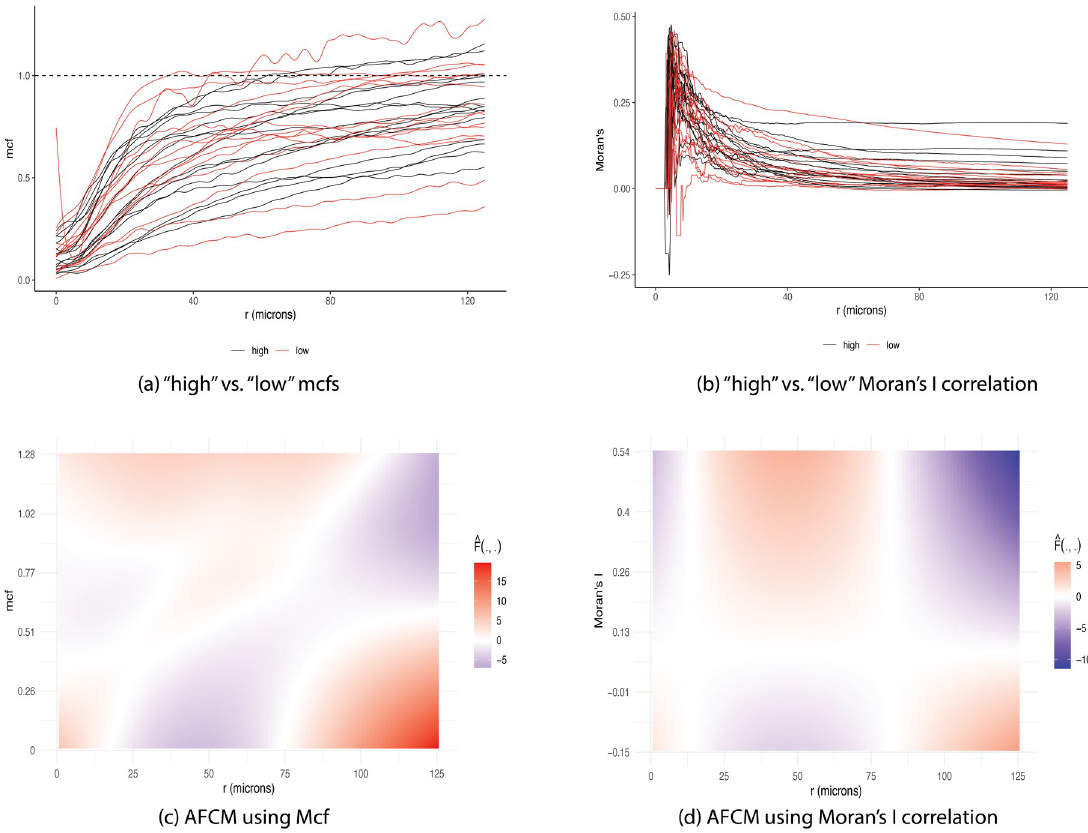
Fig 4. Estimated surface from AFCM using NSCLC dataset. (A) Mcf curves corresponding to “low” survival (i.e., shortest survival times) and “high” survival (i.e., longest observed censored times) patients in red and black, respectively. Note that mcf values below 1 indicate strong clustering of cells of same type, while values above 1 suggest higher level of mixing in of the two cell types. (B) Moran’s I correlation using MHCII expression corresponding to “low” survival (i.e., shortest survival time) and “high” survival (i.e., longest observed censored time) patients in red and black, respectively. Moran’s I values above 0 indicate a direct relationship in MHCII expression between tumor and stromal cells. Negative Moran’s I values suggest an inverse association in MHCII expression between tumor and stromal cells. (C) Estimated surface from AFCM using mcf curves as functional covariates with values decreasing from positive (red) to negative (blue). (D) Estimated surface from AFCM using Moran’s I correlation in MHCII as functional covariates with values decreased from positive (red) to negative (blue). Positive ^ F corresponds to increased risk of mortality while negative ^ F associates with reduced hazard of death.